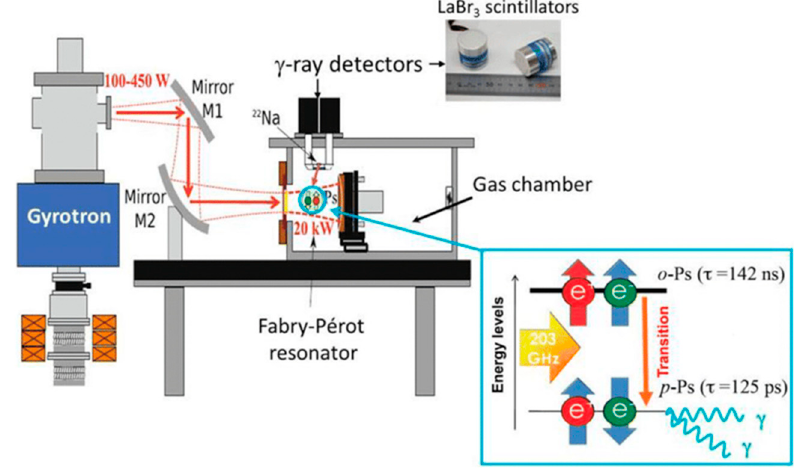
Figure 6. Schematics of the experimental setup.